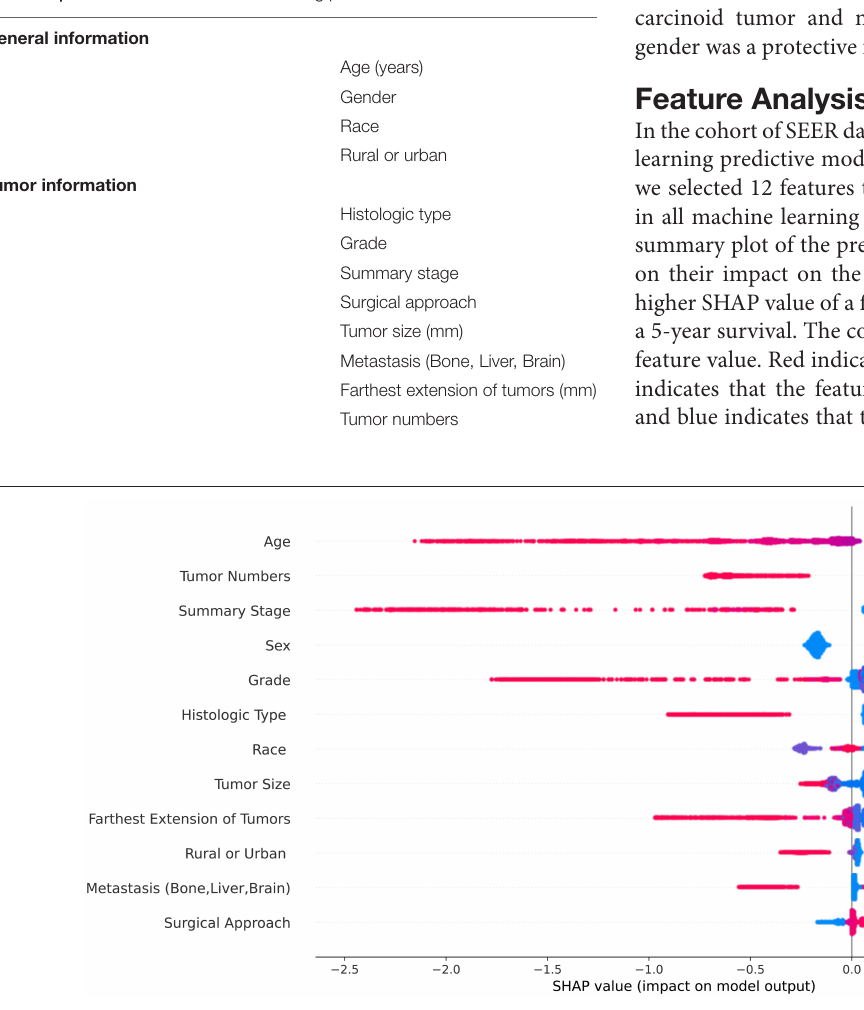
FIGURE 2 | The Shapley additive explanations summary plot of the predictive model ordered 12 features based on their impact on the 5-year survival status. The red dot represents the high value of the feature and the blue dot represents the low value of the feature.